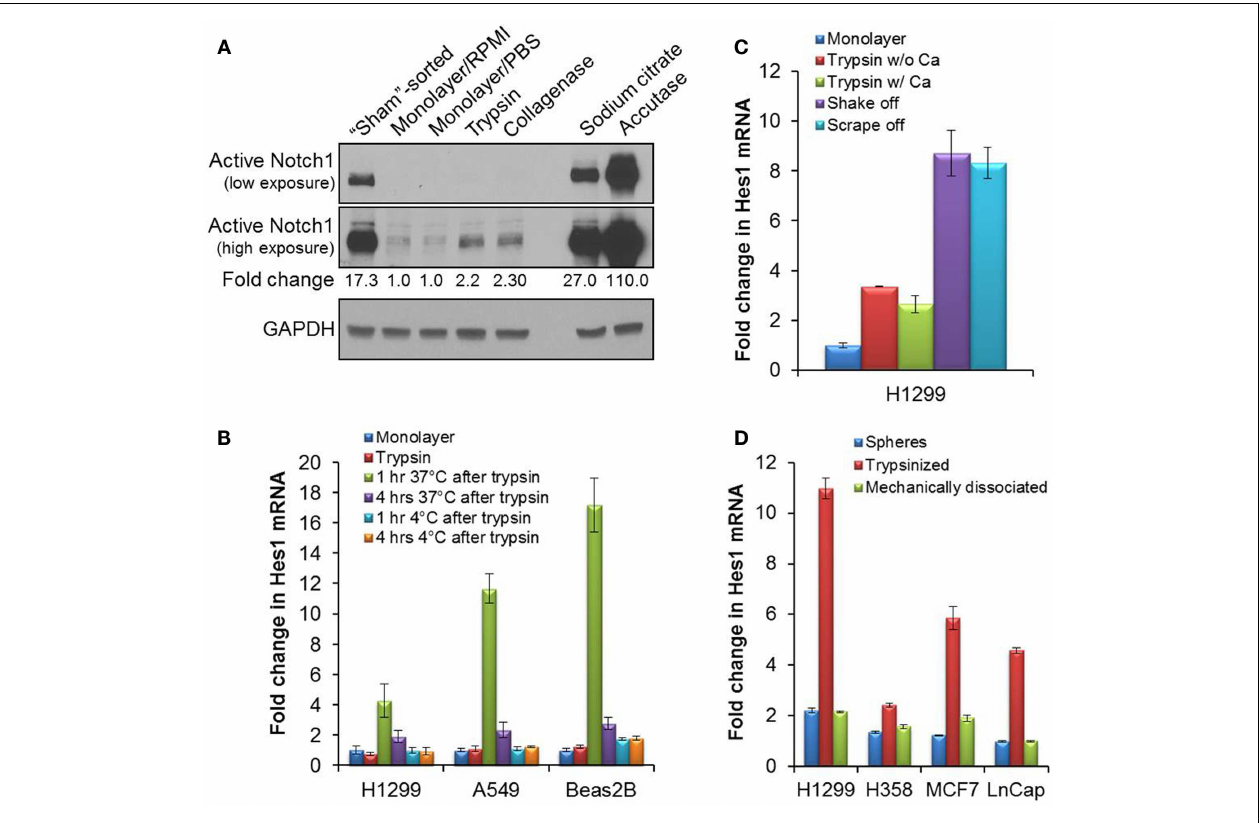
trypsinization. (C) Quantitative RT-PCR of Hes1 from mRNA collected from attached H1299 monolayer cells, or after incubation of H1299 cells at 37°C, 5% CO 2 for 1h after cell detachment by trypsin without (w/o) or with (w/) 0.5mM CaCl 2 , by gentle agitation (shake off) or by cell-scraping (scrape off). (D) Quantitative RT-PCR of Hes1 from mRNA samples collected from tumorspheres or from dissociated tumorsphere cells that were incubated at 37°C, 5% CO 2 for 1h after dissociation either enzymatically by trypsinization or mechanically by pipetting. Error bars represent standard